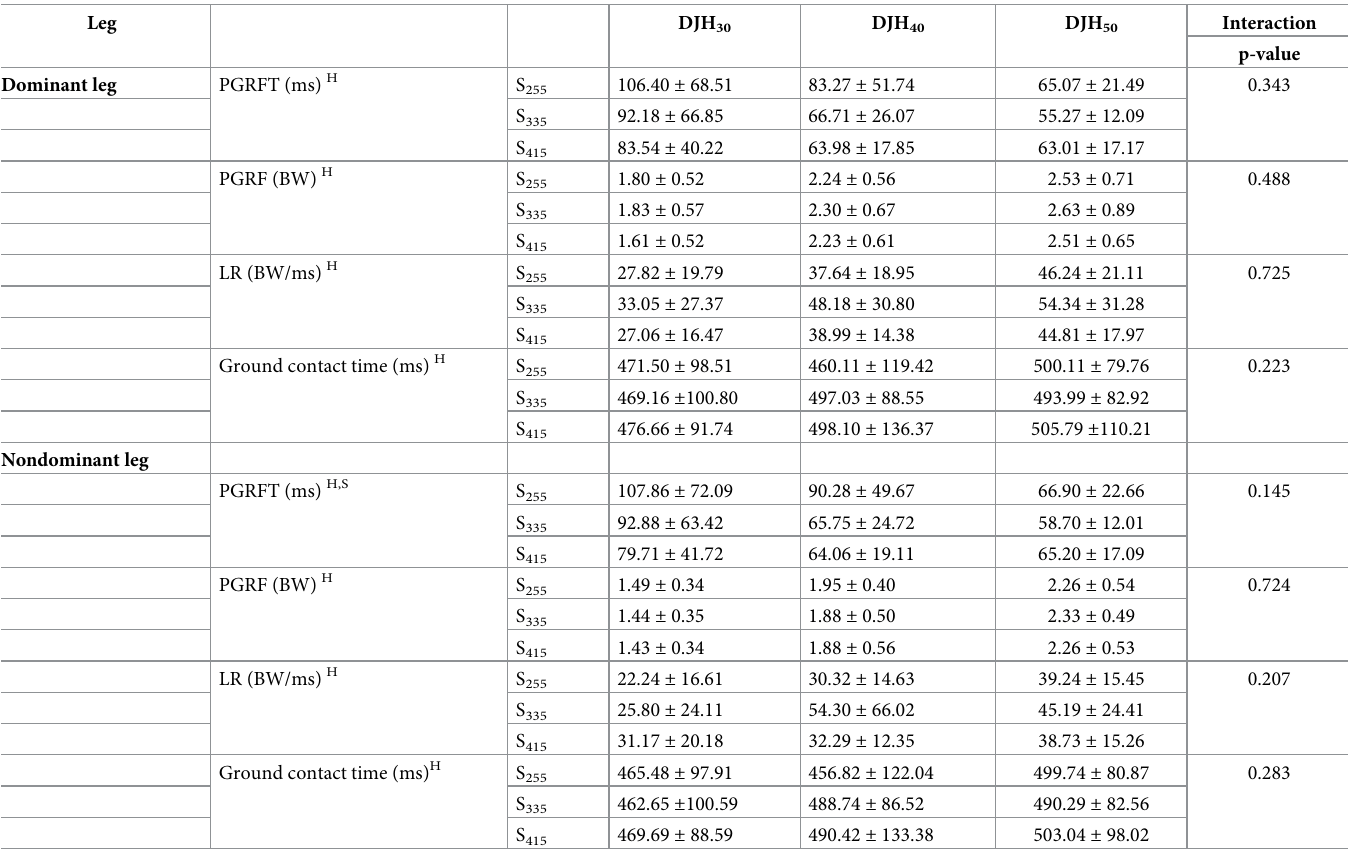
Table 1. Dominant leg and nondominant leg: Mean (SD) with the different shoe weights during DJs from 3 heights.